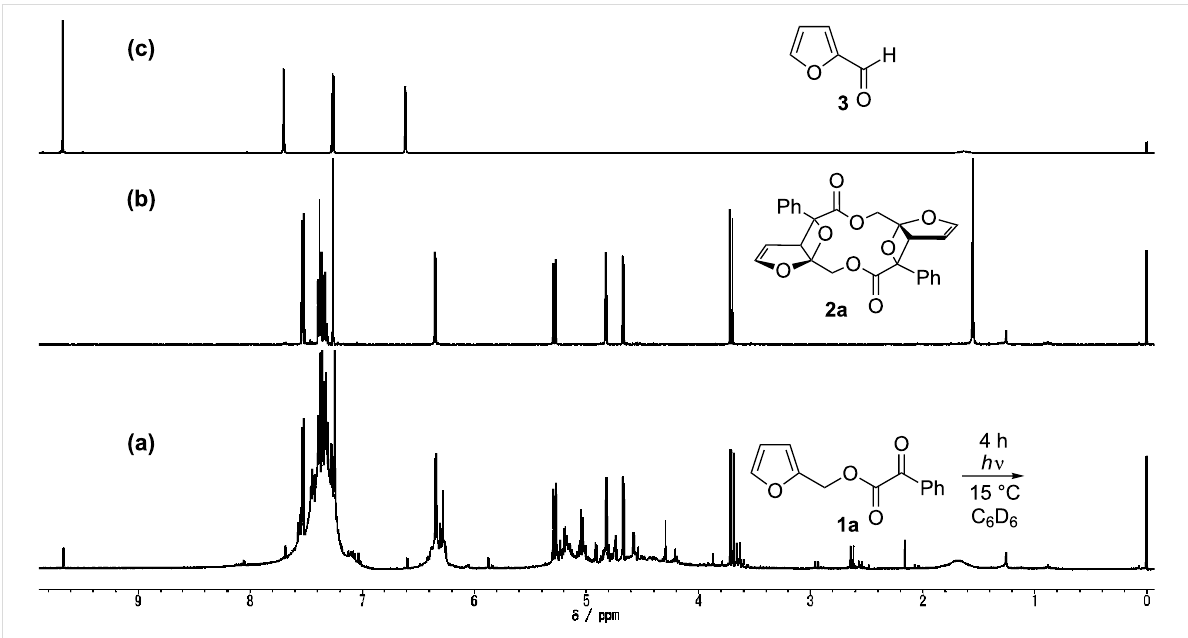
Figure 2: 1 H NMR spectra (500 MHz) for (a) the photolysate of 1a after 4 h irradiation in degassed and dried C 6 D 6 solution, (b) for isolated macro- cyclic lactone 2a , and (c) for furan-2-carbaldehyde ( 3 ).